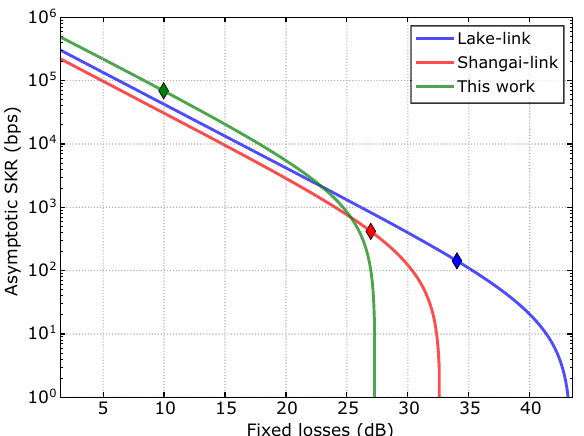
Fig. 5 Simulation of the asymptotic secret-key-rate for this work and the experiments in refs. 28,29 , as a function of the fi xed losses. The diamonds represent the best QKD run reported for each